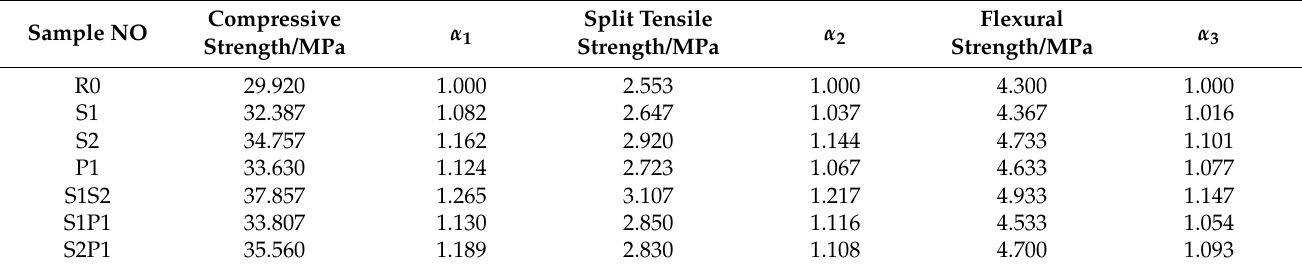
Table 4. Mechanical properties and enhancement